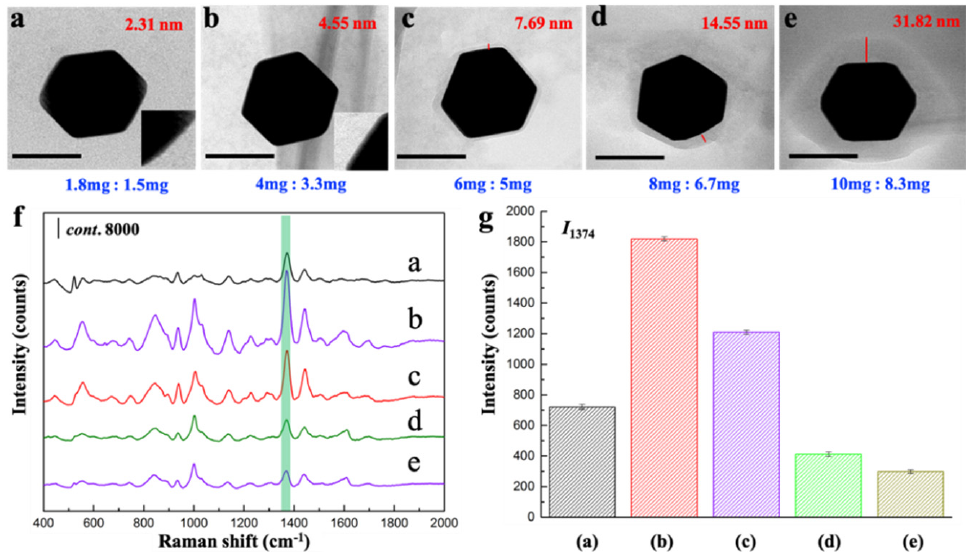
Figure 5. ( a – e ) Representative TEM images of core-shell Au@BUT-17 NP prepared with increased amount of MOF precursors (mg). Scale bar: 100 nm; ( f ) SERS spectra of thiram; and ( g ) the comparison of I 1374 in the presence of Au@BUT-17 prepared in different amounts of MOF